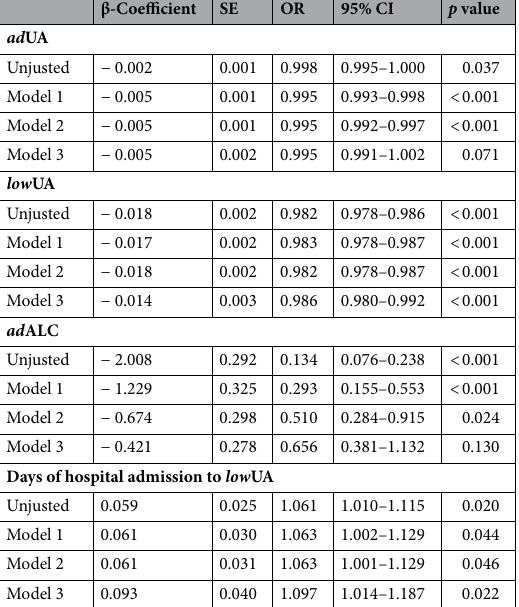
Table 2. Logistic regression analysis for ad UA, low UA, ad ALC and days to low UA to predict the death of COVID-19 patients. Model 1: adjusted for age, gender; Model 2: Model 1 + hypertension, diabetes, CHD; Model 3: Model 2 + WBC, cTnI, hs-CRP and